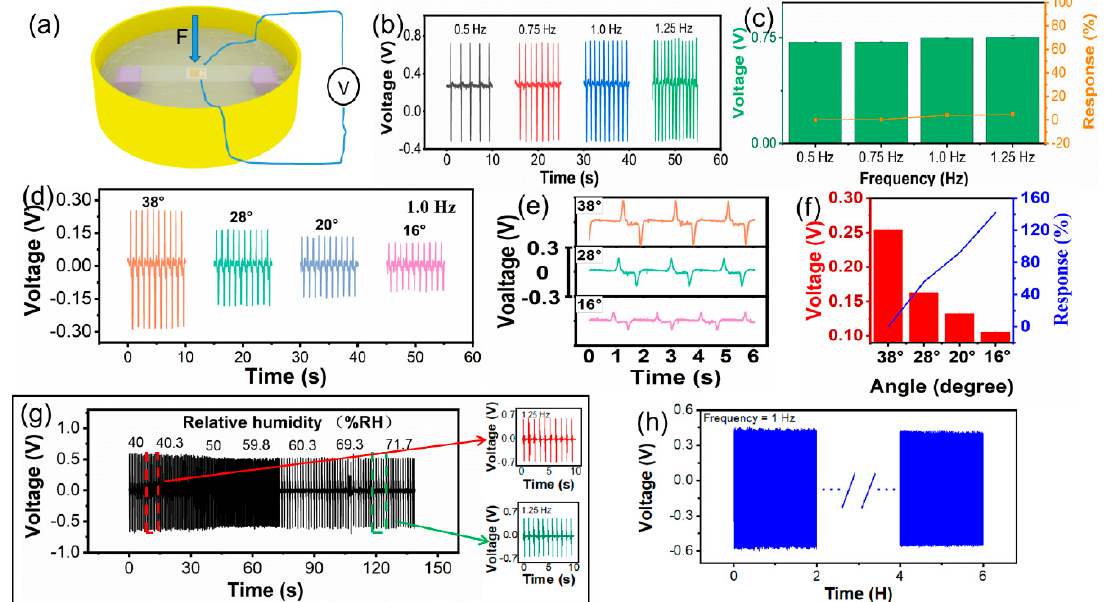
Figure 3. Experimental control of the self-powered biosensor. ( a ) Simulated experimental control of testing environment. ( b ) Output piezoelectric voltage at different motion frequencies. ( c ) Output piezoelectric voltage response at different frequencies. ( d ) Output piezoelectric voltage at the same frequency and different angles. ( e ) Details of output piezoelectric voltage of angle variation. ( f ) Output piezoelectric voltage response of angle variation. ( g ) Output piezoelectric voltage at different humidity levels. ( h ) Biosensor durability.